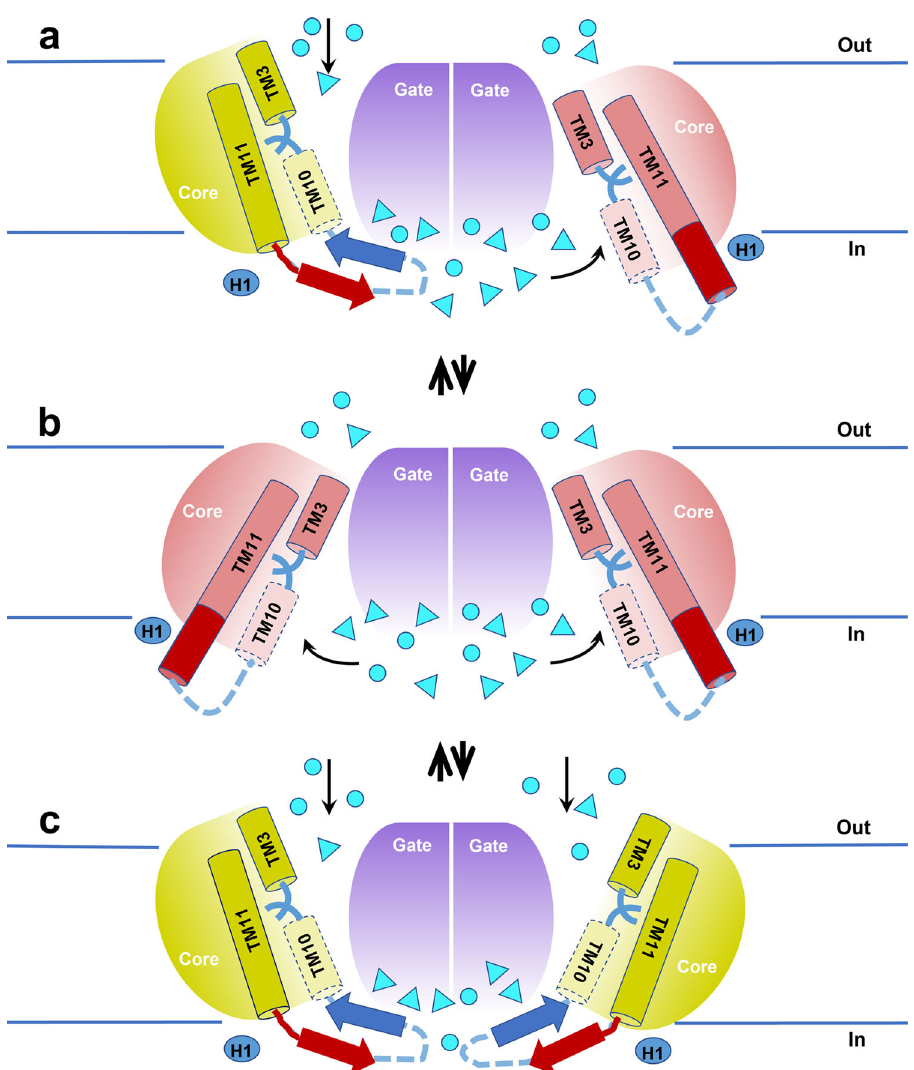
Fig. 7 Schematic representation of the transport mechanism of bAE1. Coexisting mixed OF – IF a , IF – IF b , and OF – OF c dimers. The relevant TMs (3, 10, and 11) are shown as cylinders. The core domain shifts up and down and rotates in an elevator-like motion with respect to the gate, which uncovers the center of the protein at the cross points of TMs 3 and 10 to either the extracellular or the intracellular solution. The elevator-like motion is combined with α - helical to β -hairpin conformational changes in TM11 and IL5 between TMs 10 and 11. The area of TM11 which unfolds and forms part of the β -hairpin (thick blue and red arrows) of IL5 in the OF state is shown as a red cylinder. The position of H1 with respect to TM11 in the IF and OF states is also included in the − and Cl − ions are shown as cyan triangles and spheres, respectively, and their entry pathways in the protein center in the IF and OF fi gure. The HCO 3 monomers are indicated with black arrows. In the IF state the anions accumulated in the reservoir at the dimeric interface at the intracellular side of the protein move laterally into the IF cavity. In the OF monomers the anions diffuse vertically into the OF cavity directly from the extracellular helix D in its C-terminus 45 , activation of the bacterial thermosensor DesK that involves elongation of its transmembrane helix 46 , and T cell receptor major histocompatibility complexes (MHC) interac- tion that involves MHC alpha helices conformational changes 47 .